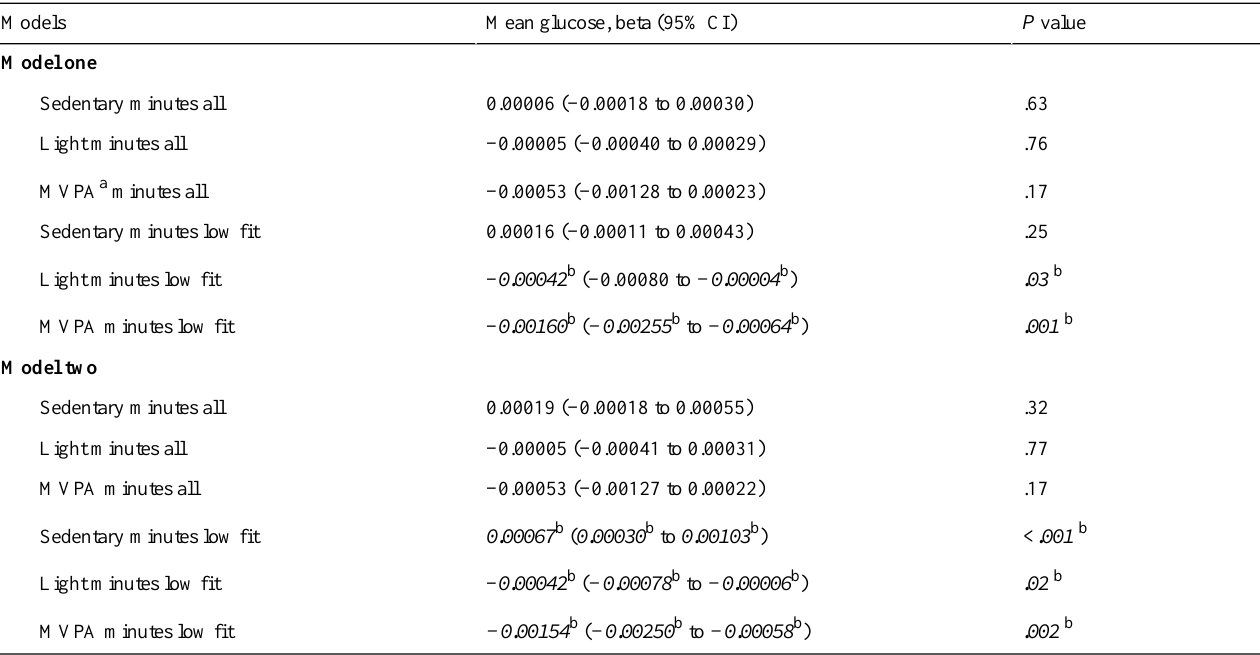
Table 3. Associations between physical activity and mean glucose for the whole sample and for the low fitness group. Model one represents a univariable association, and model two is adjusted for wear minutes, age, sex, and percentage body fat.